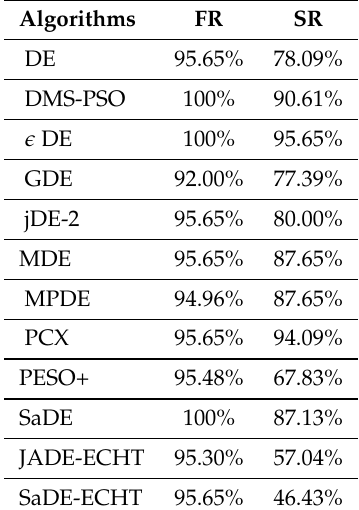
Table 7. Comparison of JADE-ECHT and SaDE-ECHT in terms of feasibility rate (FR) and success rate (SR) with algorithms of CEC